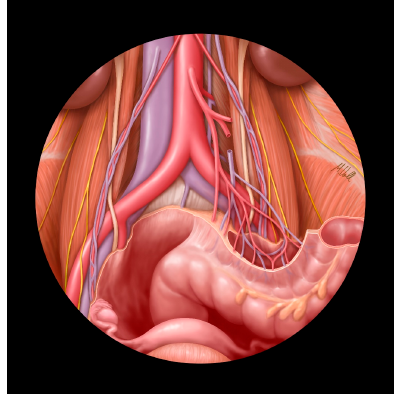
Figure 6. Schematic illustration of the anatomical area. This view is from the caudal–ventral aspect. The parietal peritoneum and the organs of the gastrointestinal tract to the sigmoid colon have been removed. The especially-complex anatomical area is on the left side, specifically the left common iliac artery and vein.